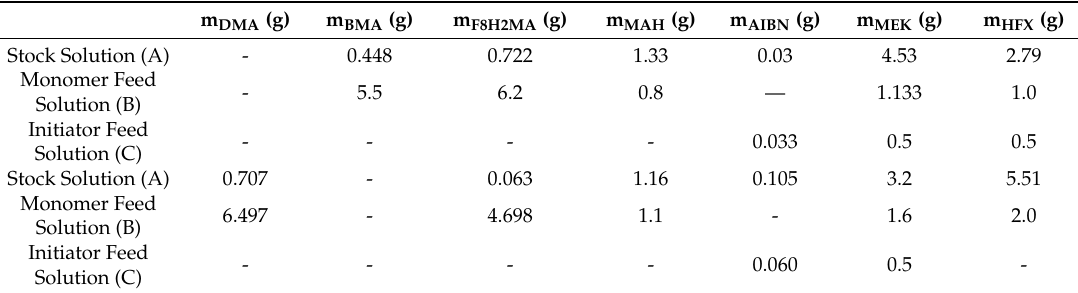
Table 2. Composition of the Stock- and Feed solutions for continuous addition terpolymerization of BMA/F8H2MA/MAH and DMA/F8H2MA/MAH ( T = 65 ◦